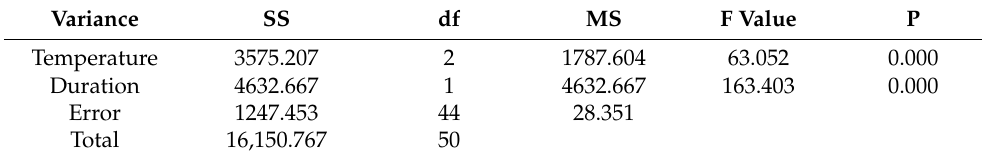
Table 3. GLM univariate analysis of the incidence of high-temperature-induced fertile pollen.